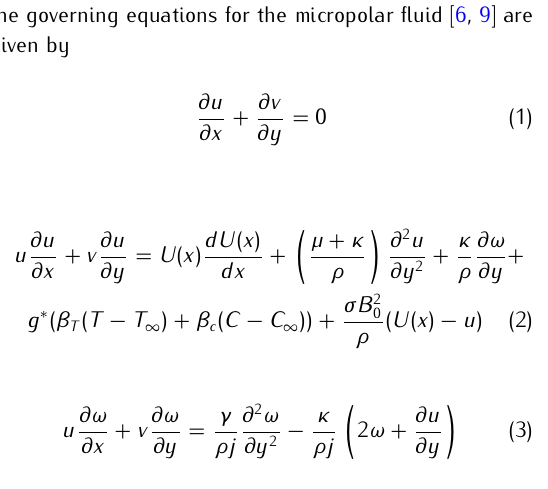
netic field. The physical model and coordinate system are shown in Fig.(1). In addition, the Soret and Dufour effects are